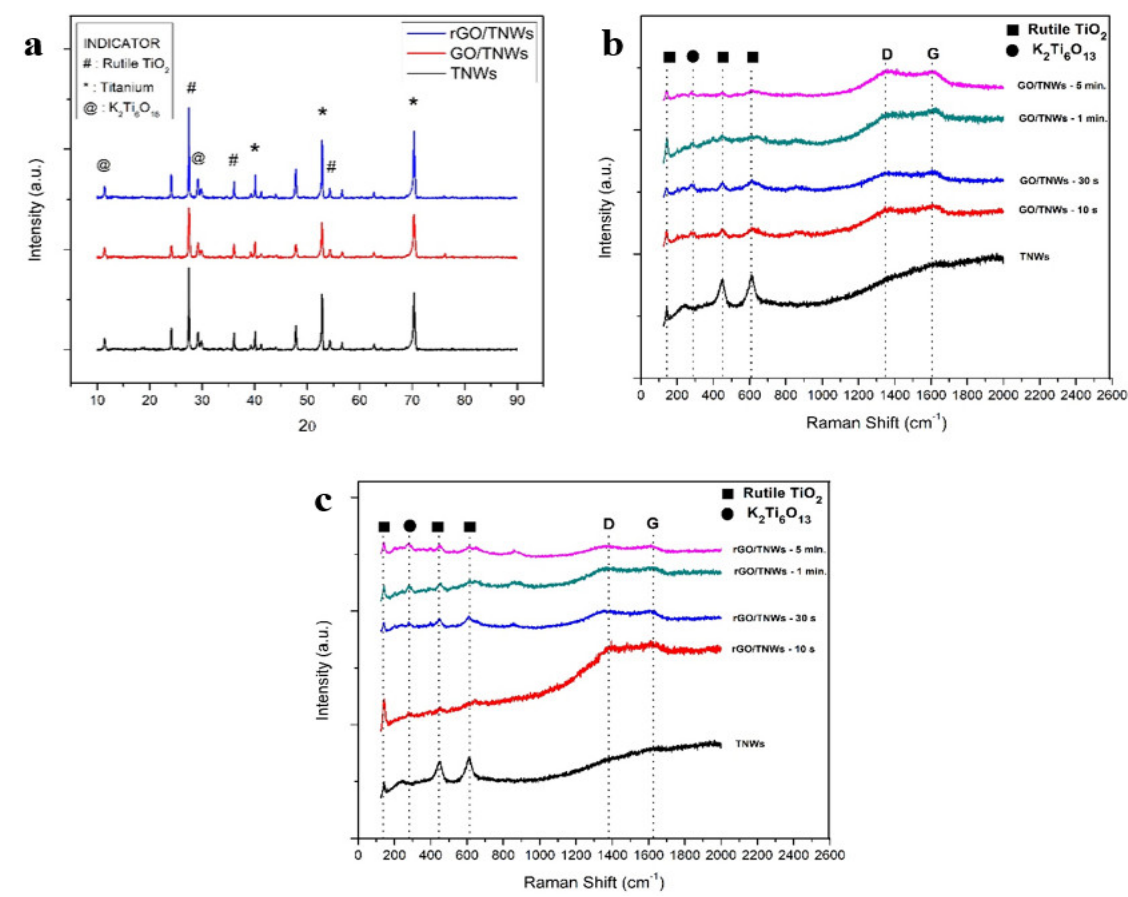
Figure 4. ( a ) XRD patterns of TNWs, GO/TNWs, and rGO/TNWs samples; ( b ) Raman spectra of TNWs and GO/TNWs samples with different deposition times; and ( c ) Raman spectra of TNWs and rGO/TNWs samples with different deposition times.